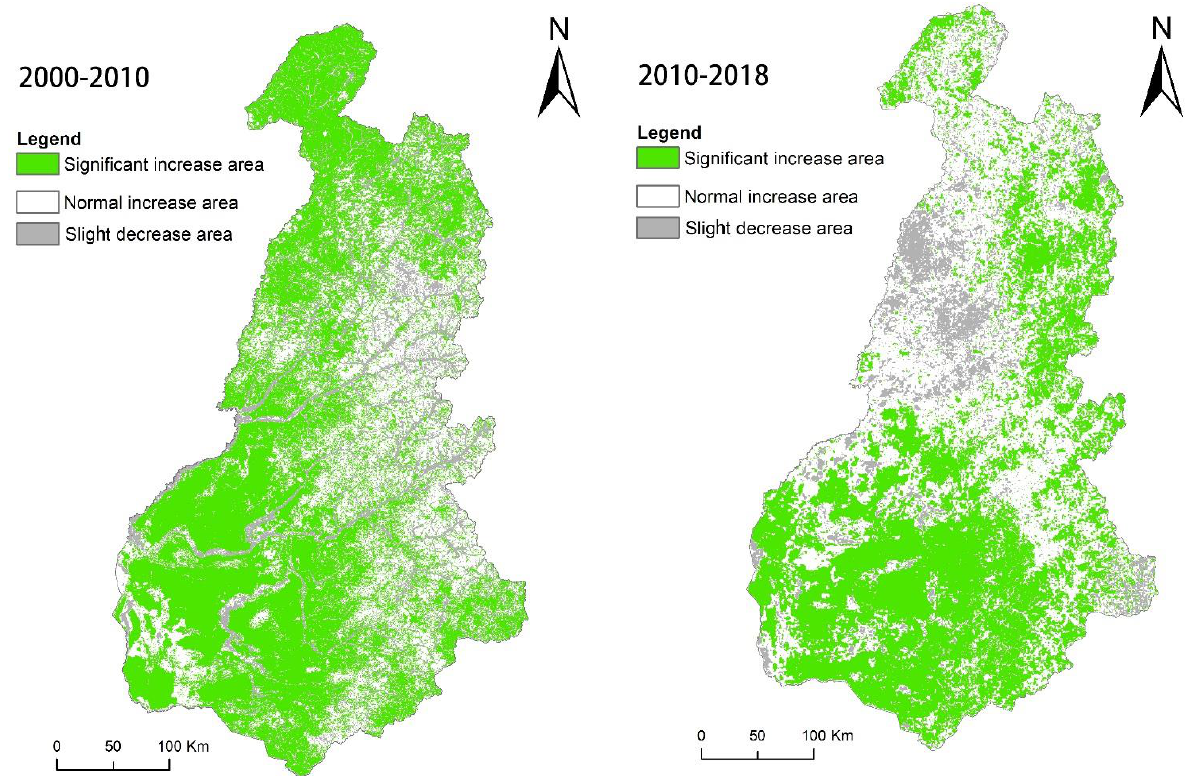
Figure 11. NPP change in the forest-steppe ecotone from 2000 to 2010 (left) and from 2010 to 2018 (right).